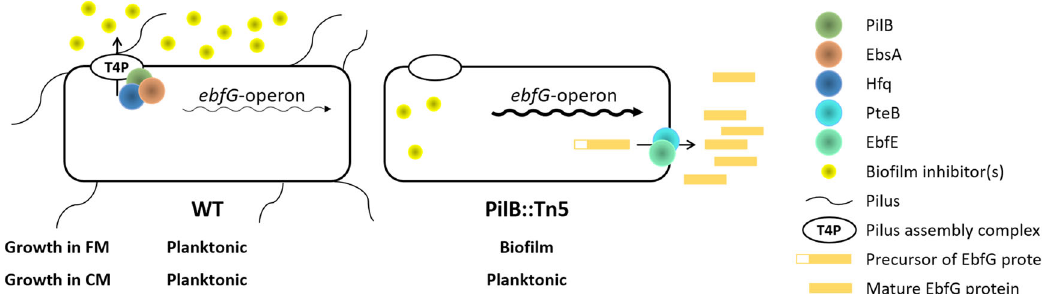
Fig. 1 Bio fi lm regulation in S. elongatus by an extracellular inhibitor that dictates transcription of the ebfG -operon. The type 4 pilus (T4P) assembly complex is involved in deposition to the extracellular milieu of bio fi lm inhibitor(s), which dictate transcription of the ebfG -operon. Low and high abundance of transcripts of this operon are indicated by thin and thick arrows, respectively. FM fresh medium, CM conditioned medium.